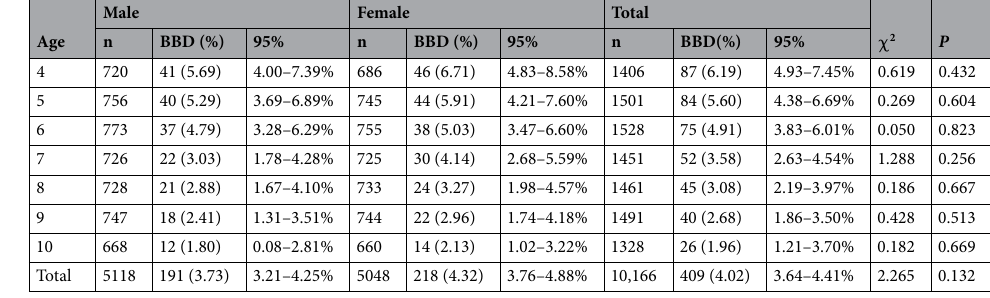
Table 1. Prevalence of BBD in children of different ages from 4 to 10 years old. * P < 0.05 was considered statistically significant.